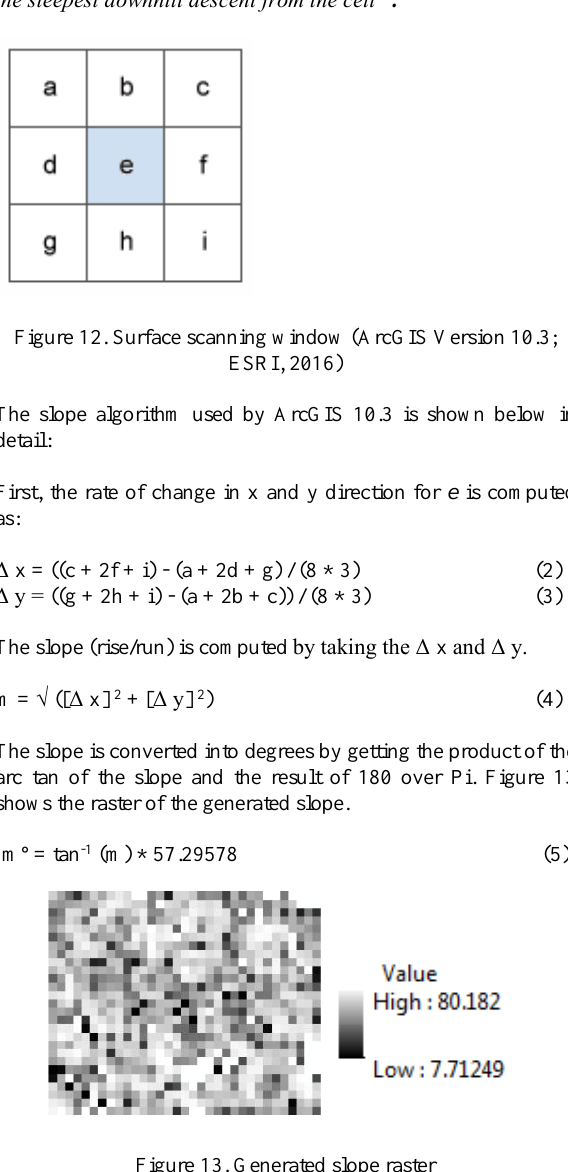
Figure 13. Generated slope raster